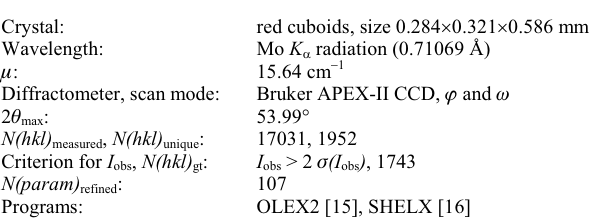
Table 1. Data collection and handling.